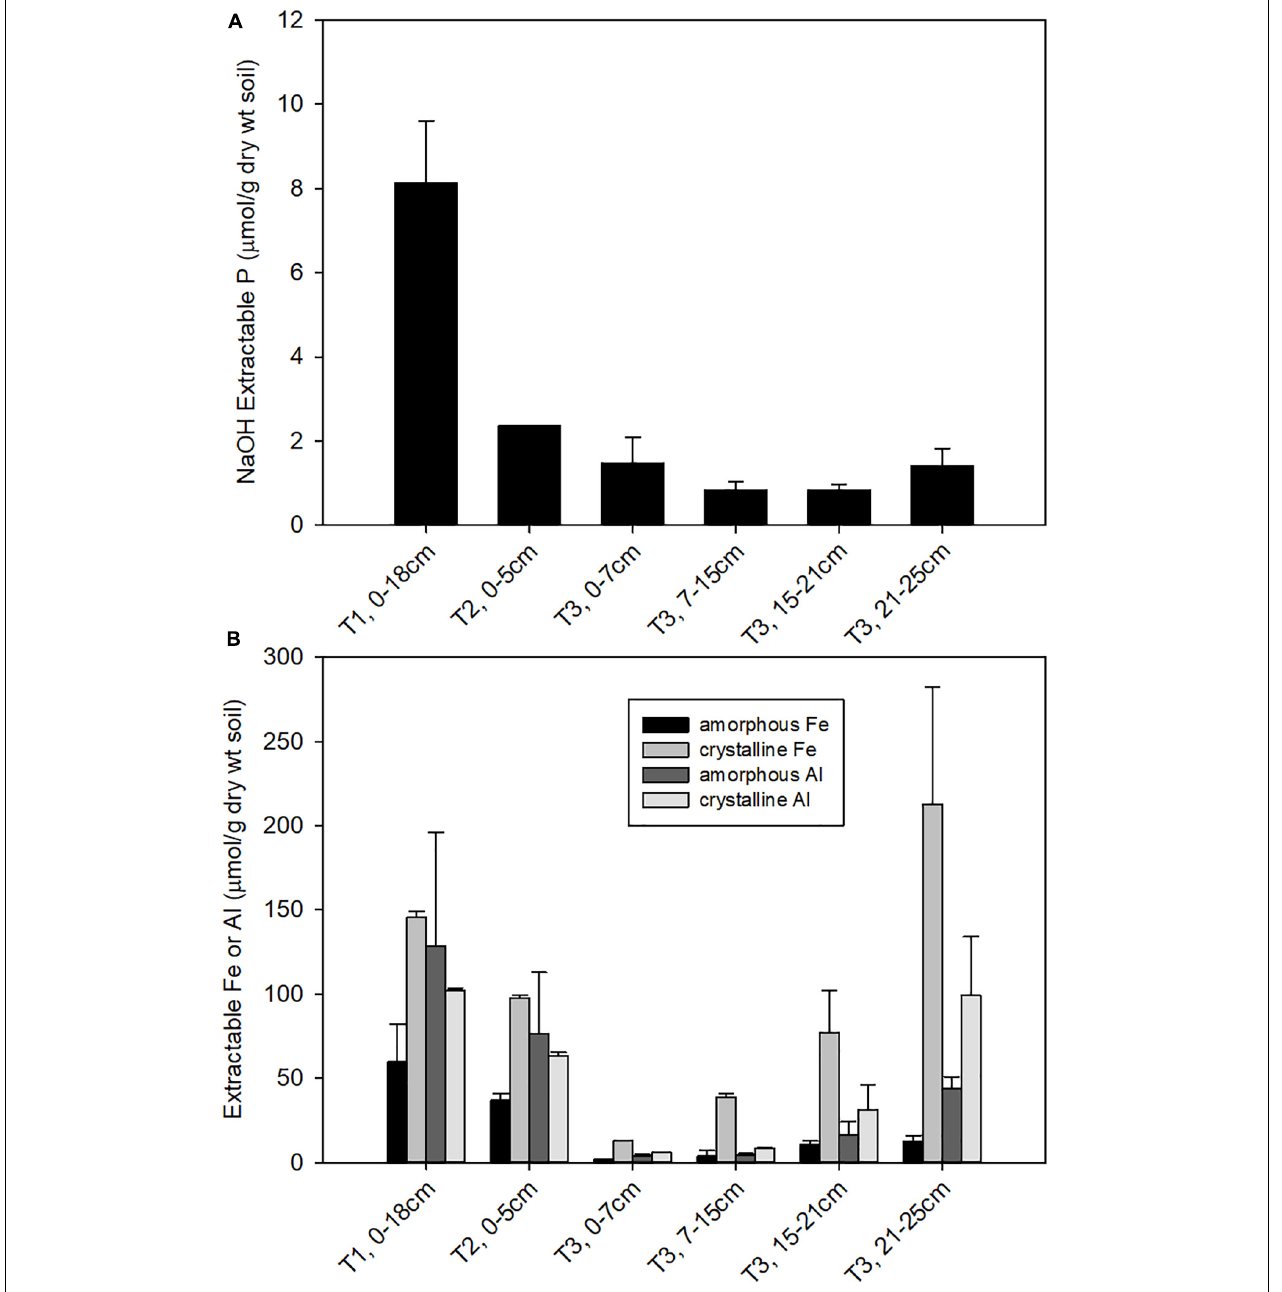
FIGURE 1 | Concentrations of (A) NaOH-EDTA extractable P, representing organic and moderately bound inorganic P; and (B) oxalate and CBD extractable Fe, representing amorphous and total free (crystalline + amorphous) iron oxide contents,